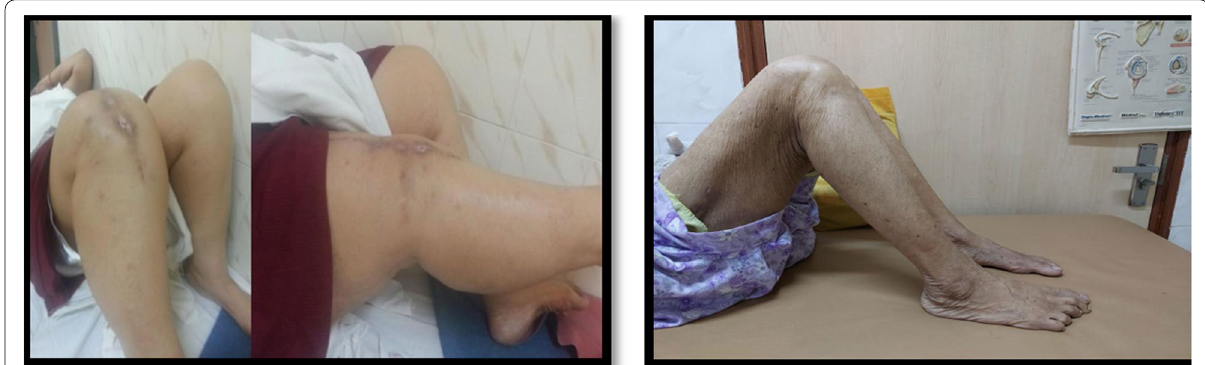
Fig. 5 a Full final function of a patient with distal femural fracture with OA knee. b Full final function of the patient with distal femural fracture with RA